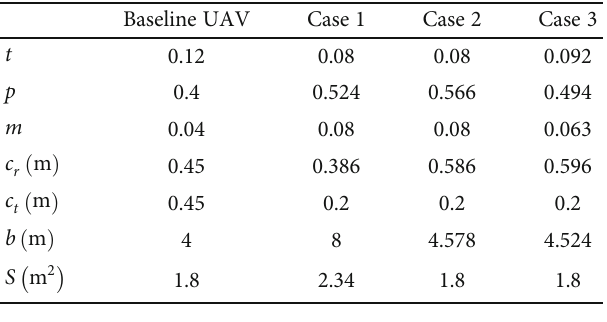
Table 5: Geometric properties of the wings of the baseline UAV and the optimum UAV wings.